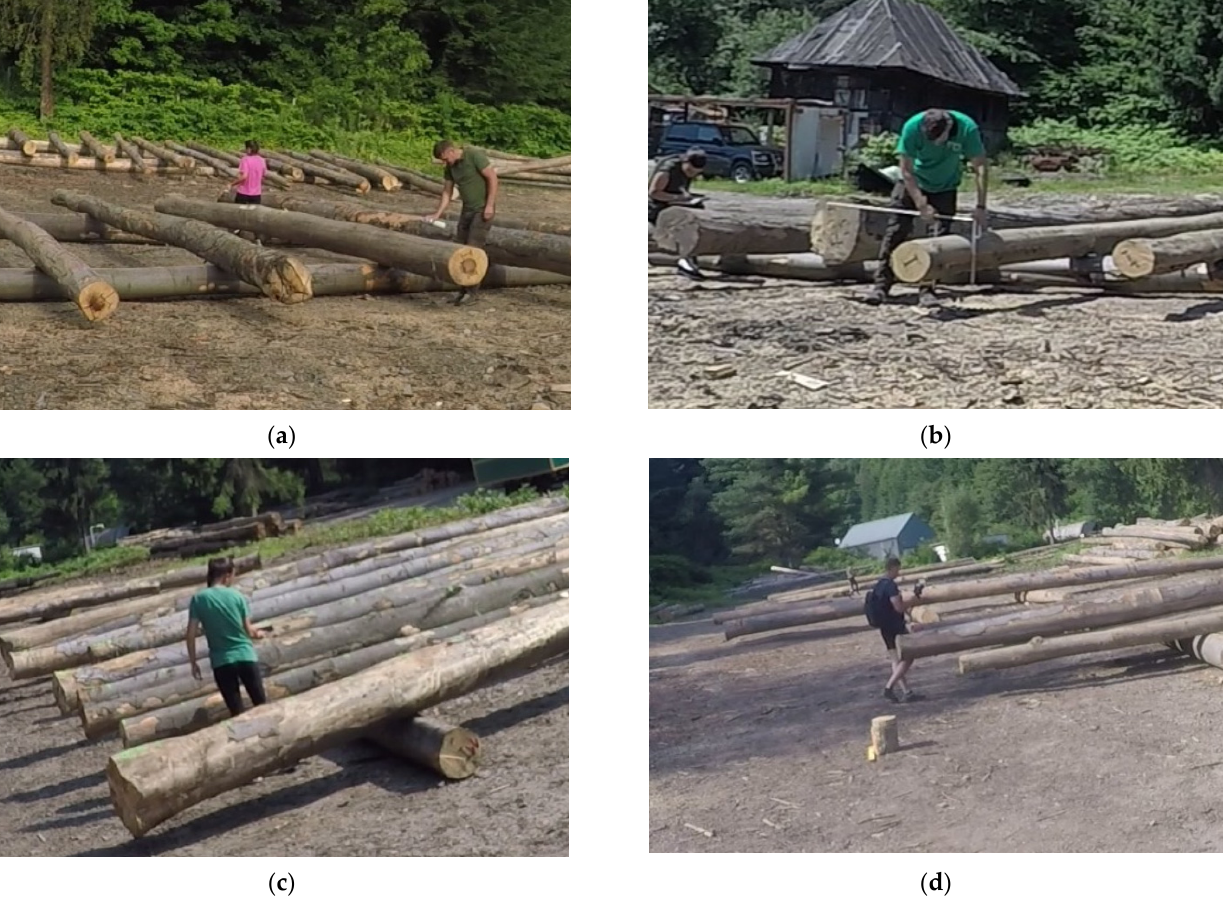
Figure 1. Examples from the operations taken into study: ( a ) log marking; ( b ) manual measurement; ( c ) scanning by a smartphone; and ( d ) scanning by a professional platform. ( c ) scanning by a smartphone; and ( d ) scanning by a professional